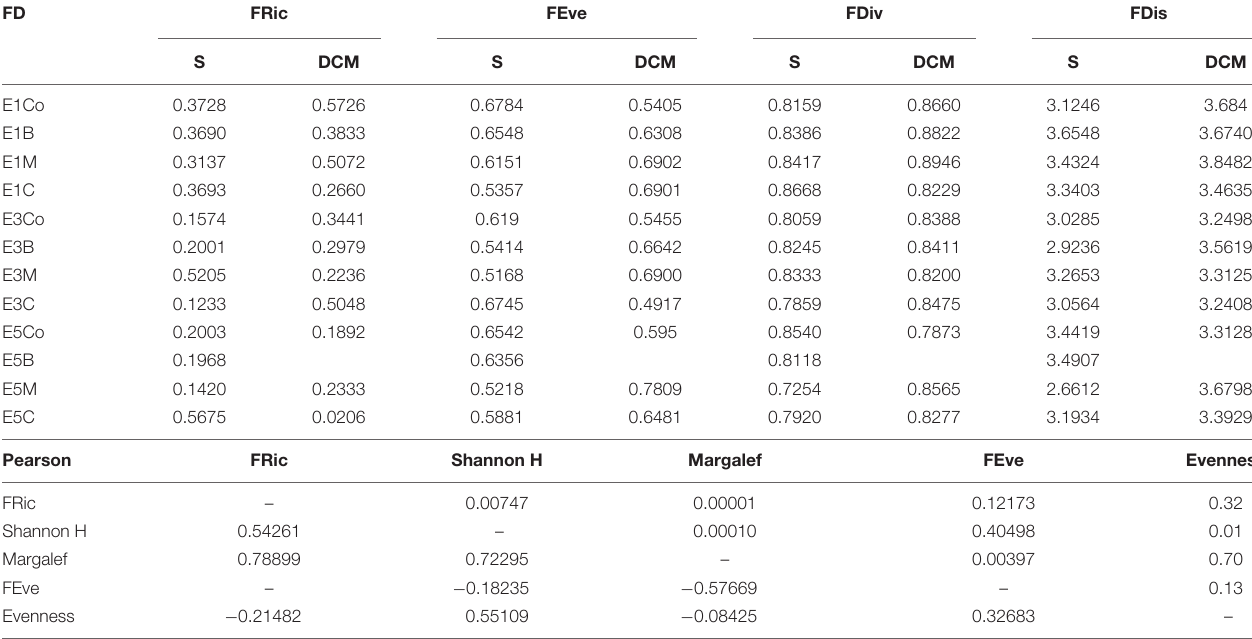
TABLE 4 | Functional traits indices: FRic, FEve, FDiv, and FDis to microphytoplankton eddies E1, E3, and E5 (Co, B, M, and C in S, surface and DCM, deep chlorophyll maximum).